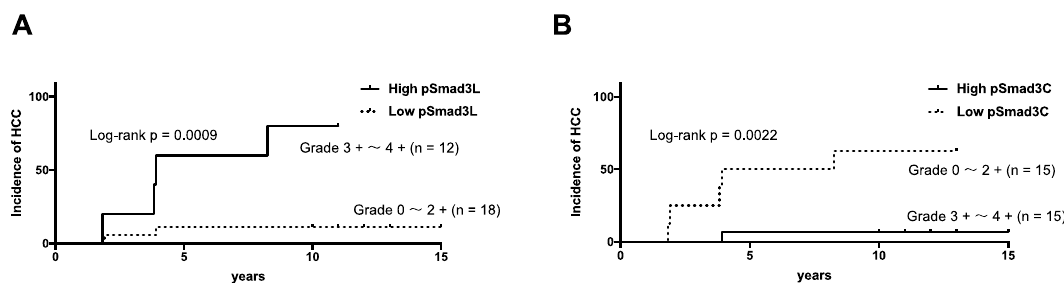
Figure 6. Nonalcoholic steatohepatitis (NASH) patients whose hepatocytes were strongly positive for pSmad3L and essentially negative for pSmad3C were more likely to develop hepatocellular carcinoma (HCC). ( A ) HCC was likely to occur among patients with NASH specimens strongly positive for pSmad3L. HCC also was significantly more likely in patients with abundant Smad3L phosphorylation (scores 3 to 4, solid line) than in those with sparse Smad3L phosphorylation (scores 0 to 2, dotted line). ( B ) HCC did not occur among patients with hepatocytes in NASH specimens strongly positive for pSmad3C. HCC incidence also was significantly higher in patients with sparse Smad3C phosphorylation (scores 0 to 2; dotted line) than in those with abundant Smad3C phosphorylation (scores 3 to 4; solid line). Occurrence rates were compared using Kaplan–Meier analysis and log ‐ rank tests. Table 3. Phospho ‐ Smad3L/C and fibrosis stage are independent predictors of HCC occurrence.